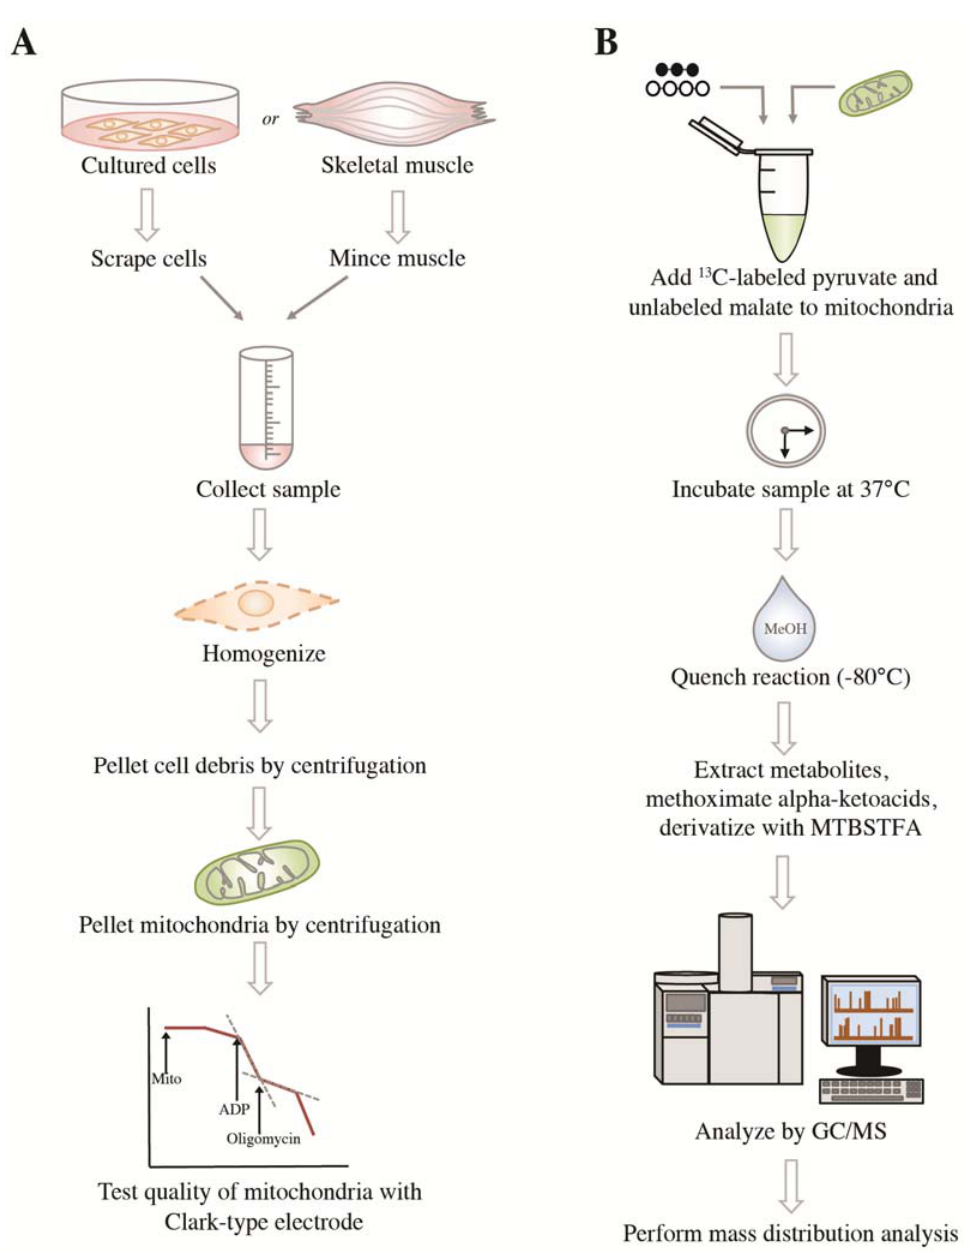
Figure 1. Schematic of experimental steps for stable isotope tracer analysis on isolated mitochondria. ( A ) Extraction of mitochondria, purification and assessment of quality. ( B ) Incubation of a fixed amount of mitochondria (evaluated by protein content) with substrates, such as 13 C-pyruvate and unlabeled malate, sample preparation